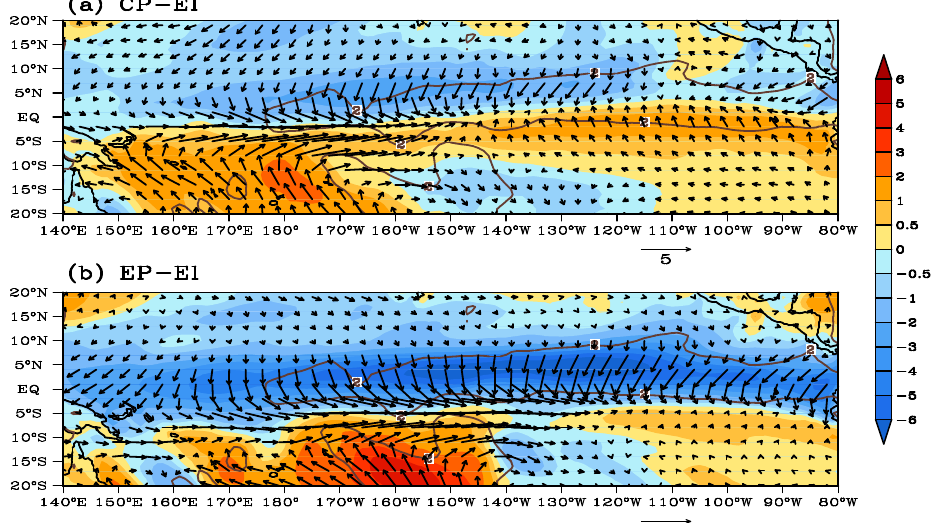
Figure 3. Low-level atmospheric wind field anomalies (vector) and meridional wind speed anomalies (color) during the mature period of two types of El Niño, unit: m/s. The area within the grey contour line passed the 95% significance test, indicating that there is a significant difference in the wind fields between two types of El Niño years.